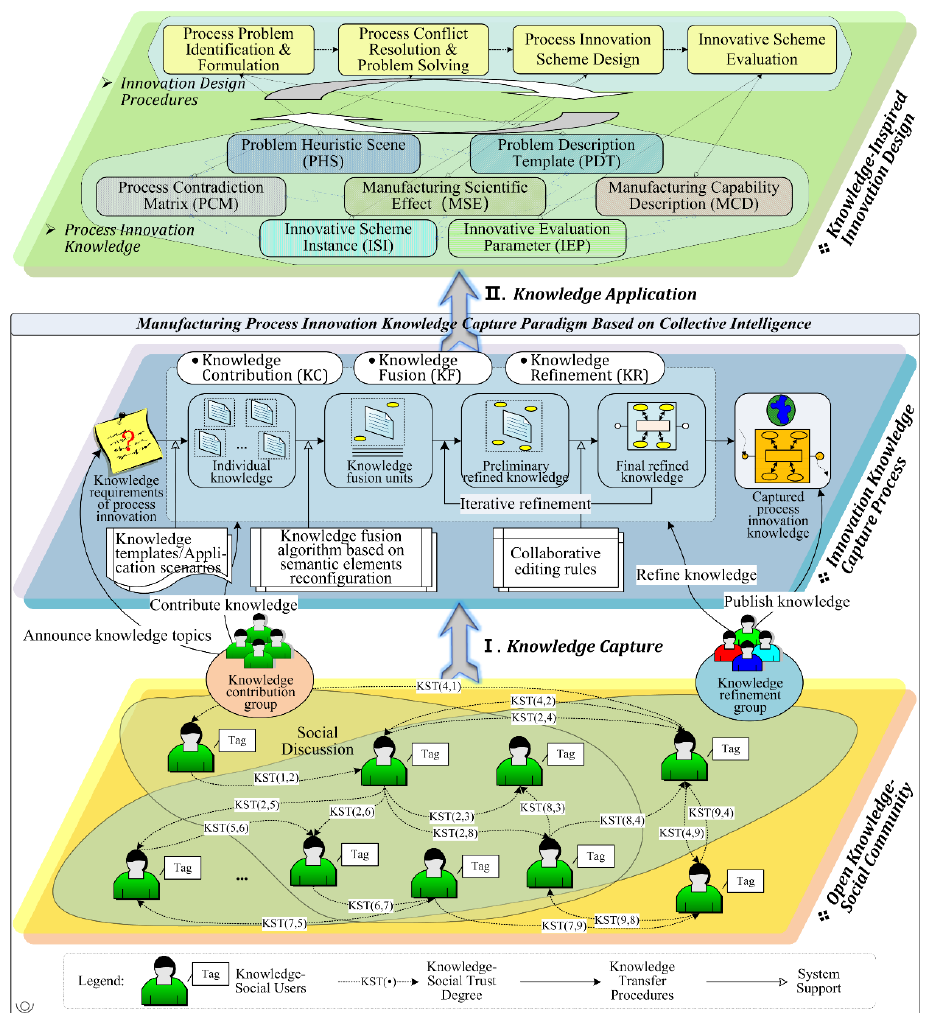
Figure 1. A novel process innovation knowledge capture paradigm based on collective intelligence.